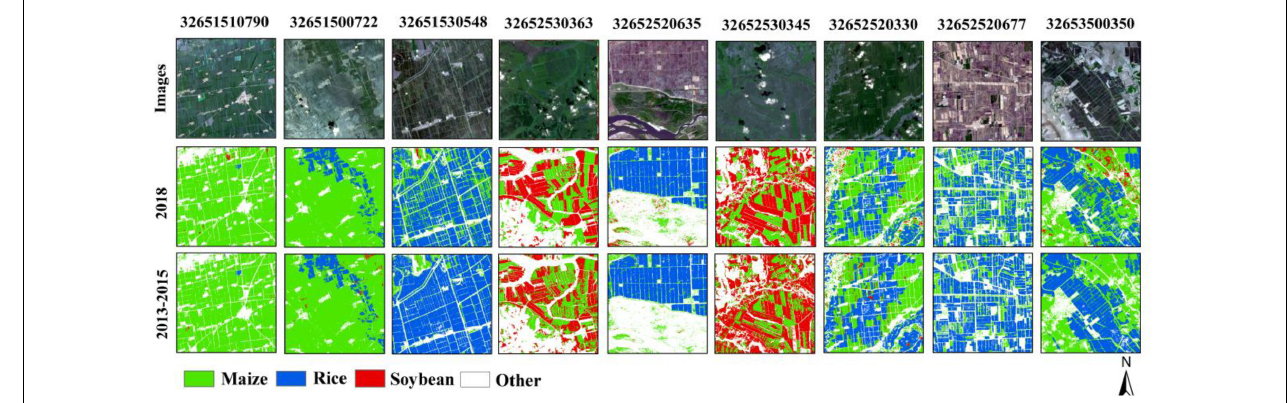
FIGURE 12 | Classification results details of Heilongjiang based on newly generated samples from 2013 to 2015 and current samples in typical